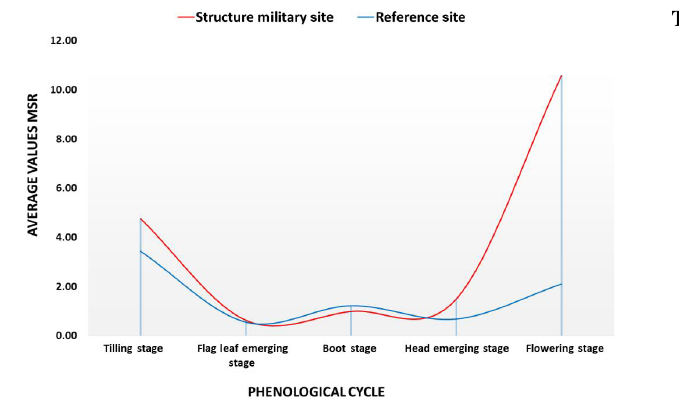
Figure 12. Same as Fig. 5, but for MSR.